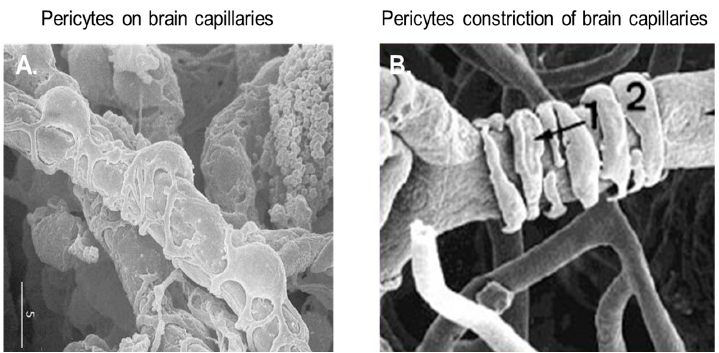
Figure 2. Brain vascular pericytes in vivo. ( A ) Pericytes on rat brain capillaries; ( B ) rat brain capillaries undergoing constriction by vascular pericytes. The marker measures 5 microns. Modified